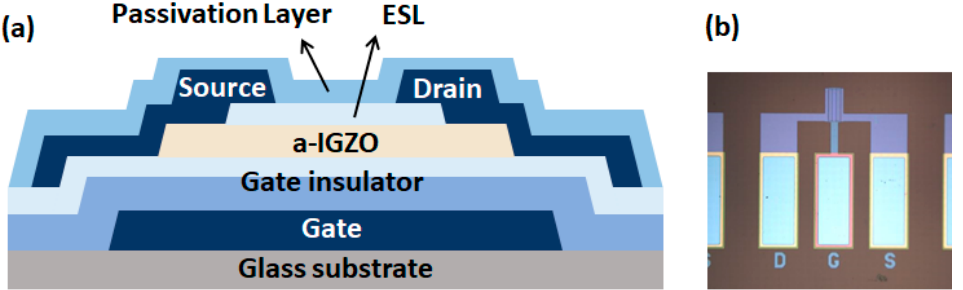
Figure 1. Amorphous InGaZnO (a-IGZO) thin-film transistor Sample: ( a ) Schematic structure of bottom-gate a-IGZO TFT device; ( b ) Top view of layout image.